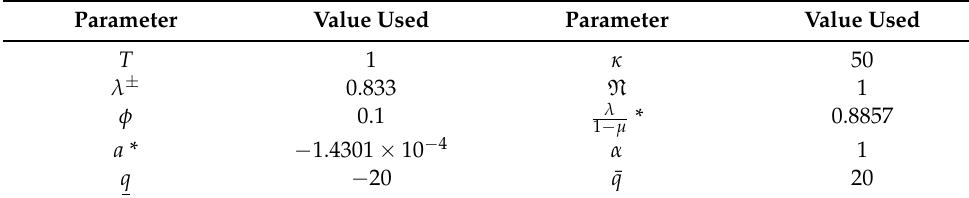
Table 10. Market-making parameters for Google stock.